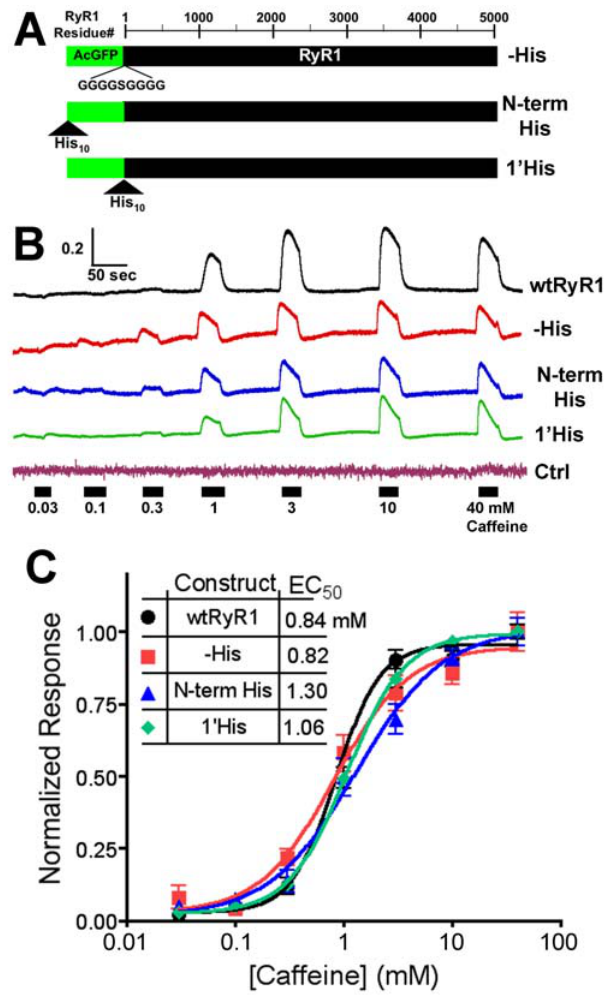
Figure 3. GFP-RyR1 fusion proteins release Ca 2 + in response to caffeine stimulation. (A) GFP-RyR1 fusion constructs tested for FRET. Bars represent amino acid sequence of GFP (green) and RyR1 (black). The sequence of the glycine rich linker between GFP and RyR1 as well as positions of inserted His 10 tags are shown. Scale indicates RyR1 amino acid number. (B) Caffeine-induced Ca 2 + transients in HEK-293T cells expressing RyR1 constructs measured using Fura-2 based Ca 2 + imaging. A graded series of caffeine concentrations were perfused at the times and concentrations indicated (black bars). Individual representative traces indicate changes in Fura-2 fluorescence excitation F340/F380 ratio. Ctrl indicates untransfected cells. Calibration bar=0.2 340/380 ratio units vs. 50 s. (C) Normalized caffeine dose response curves for the indicated constructs. Values represent mean + / 2 S.E.M. for 19–22 cells per construct. EC 50 values were calculated from the midpoint of these curves as described in Methods. No statistical difference (1-way analysis of variance (ANOVA); p , 0.05) between EC 50 values was observed.